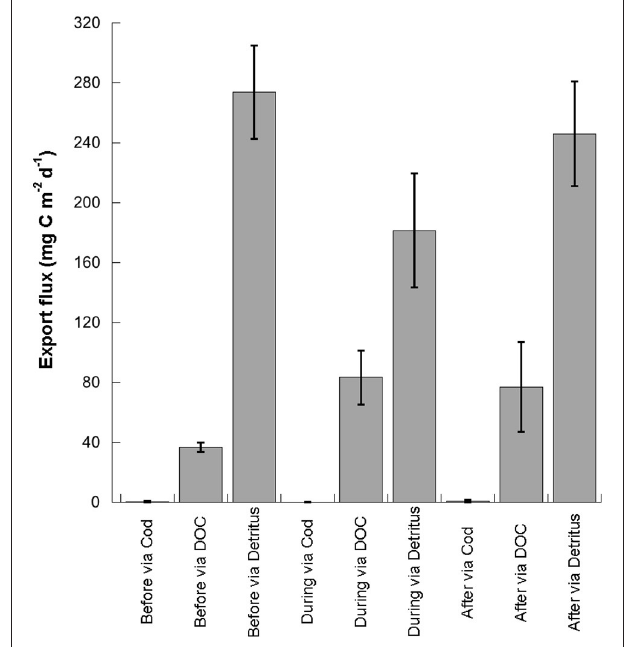
FIGURE 4 | Main pathways of carbon export, predicted by the inverse modeling, during time three periods in the Fram Strait, before, during , and after the warm water event of 2005–2007: via cod, top predator, via dissolved organic carbon (DOC) and via particulate organic carbon (POC) or detritus. Error bars indicate one standard deviation from the mean.